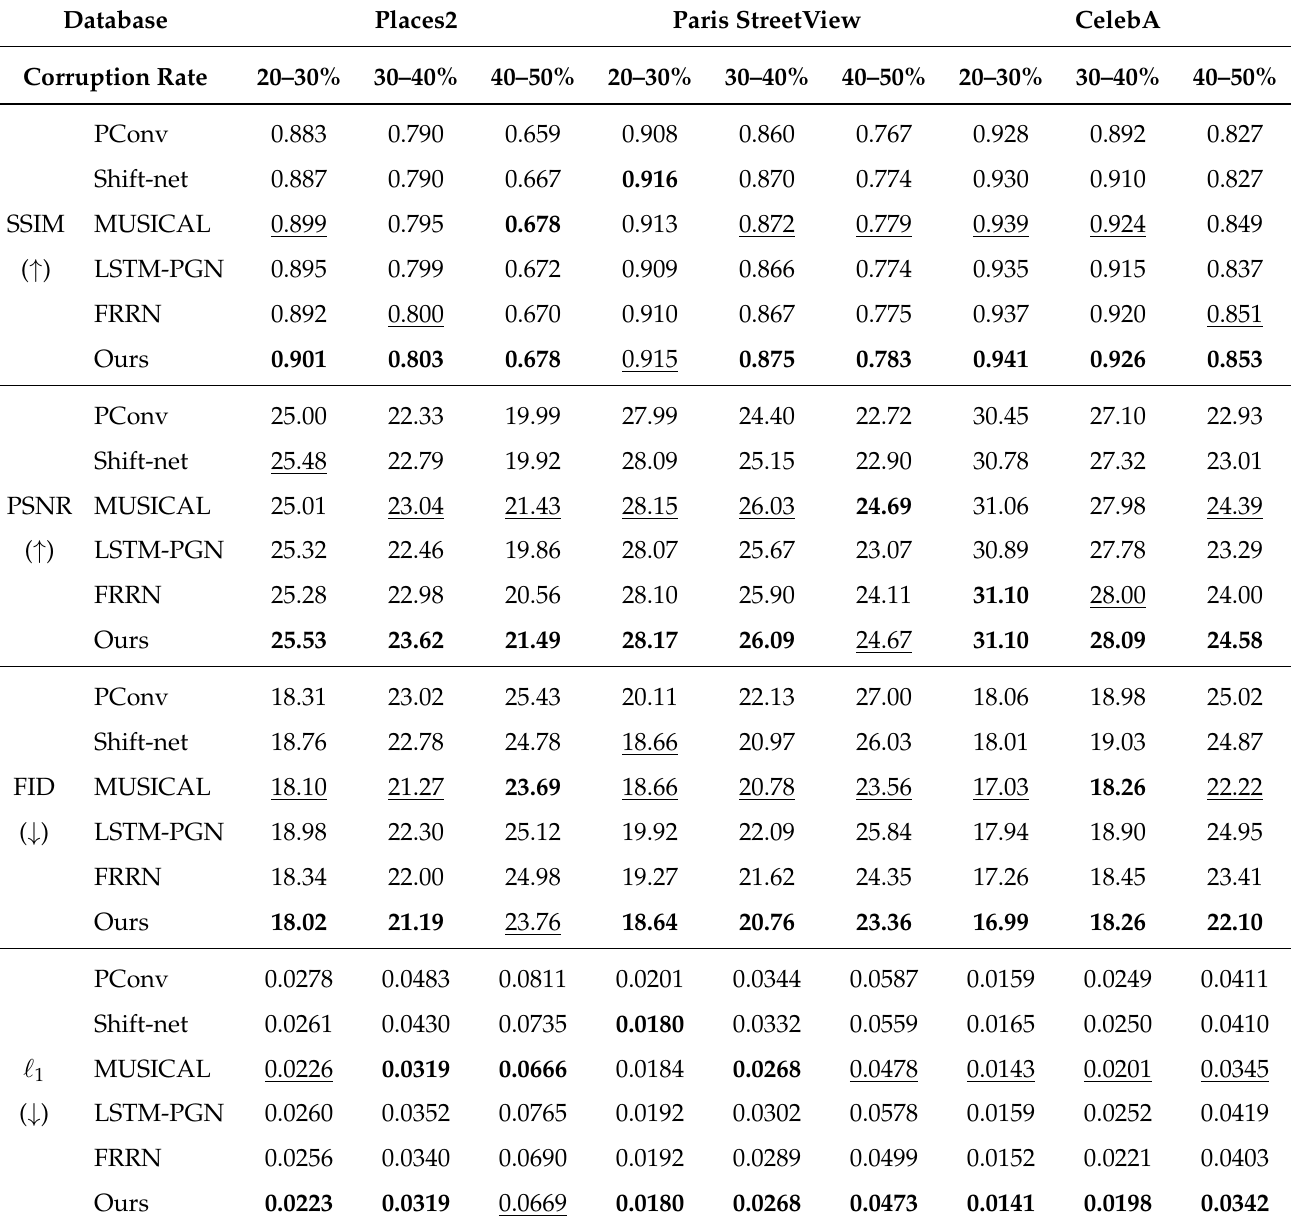
Table 1. Quantitative results for numerical comparisons. The arrow “ ↑ ” (or “ ↓ ”) is intended to indicate that a higher (or lower) value is better. The best and the second best scores are highlighted by bold and underline, respectively. Database Places2 Paris StreetView CelebA Corruption